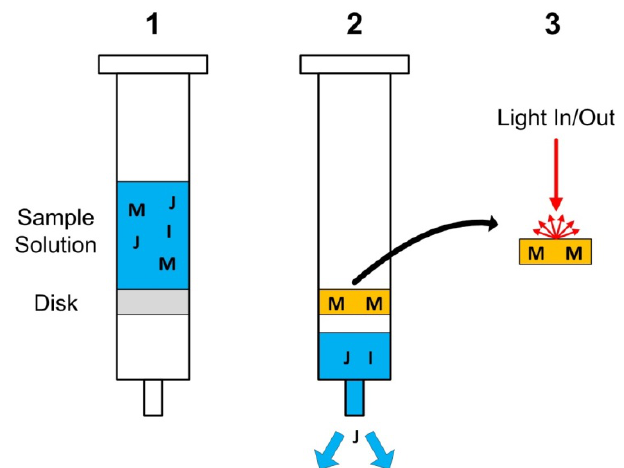
Figure 9. Simplified representation of the basic operational principles of colorimetric solid phase extraction. The sample solution of interest including impurities (I,J) is passed through a disk made up of an appropriate solid phase which extracts the analyte